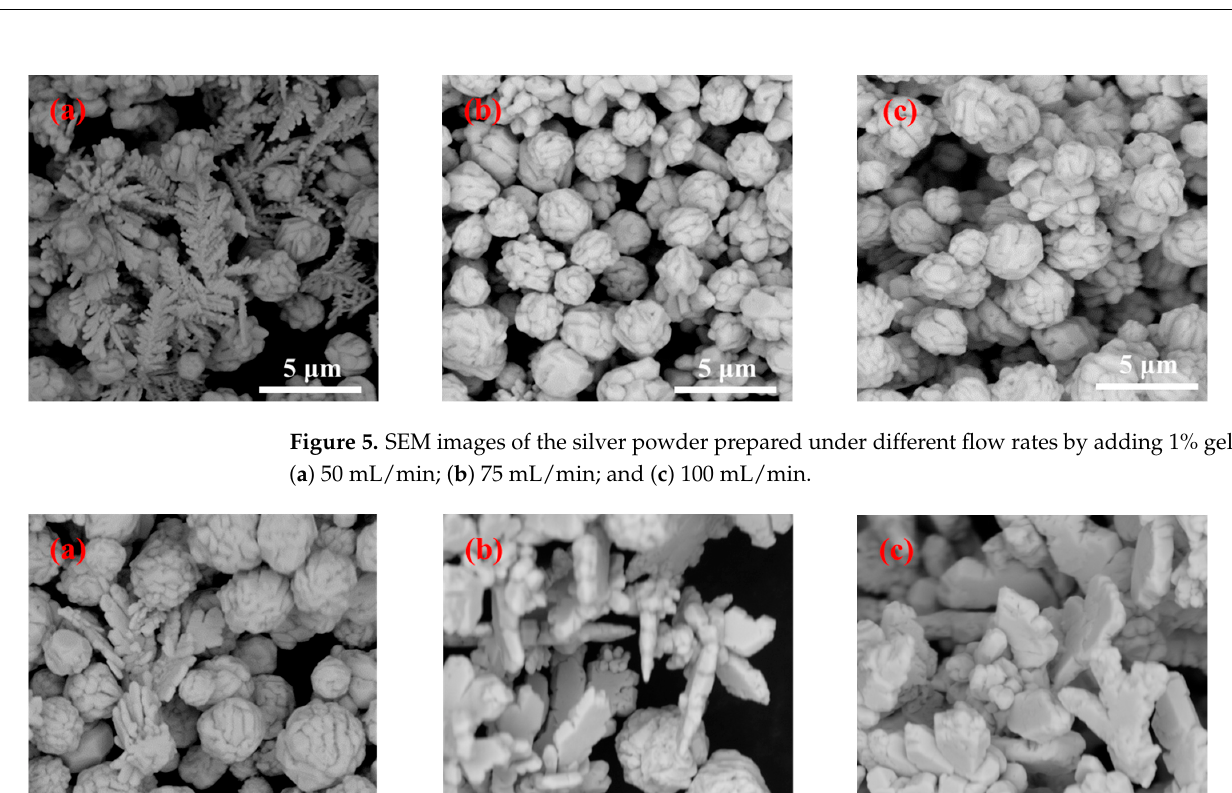
Figure 6. SEM images and particle size distribution of silver powders prepared under different flow rates by adding 1.5% gelatin. ( a ) 50 mL/min; ( b ) 75 mL/min; and ( c ) 100 mL/min.